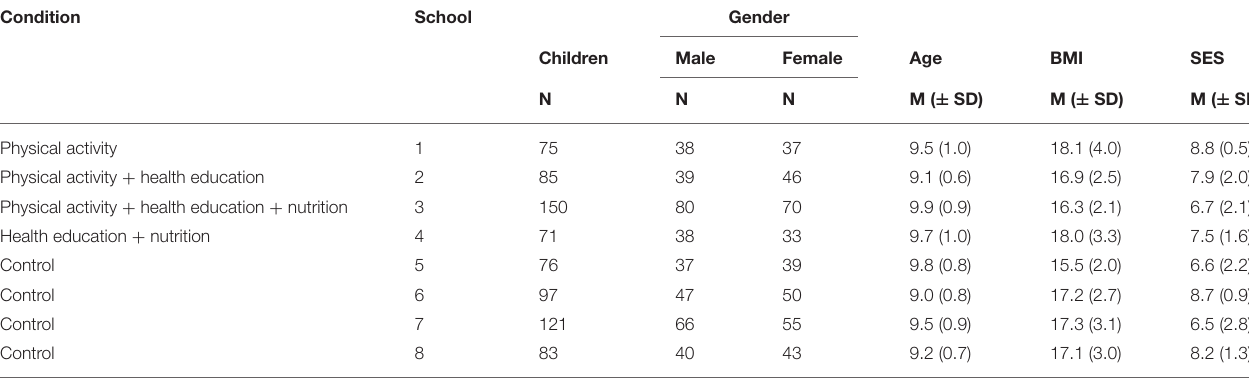
TABLE 1 | Intervention measures and baseline demographics at the eight primary schools in Port Elizabeth, South Africa.